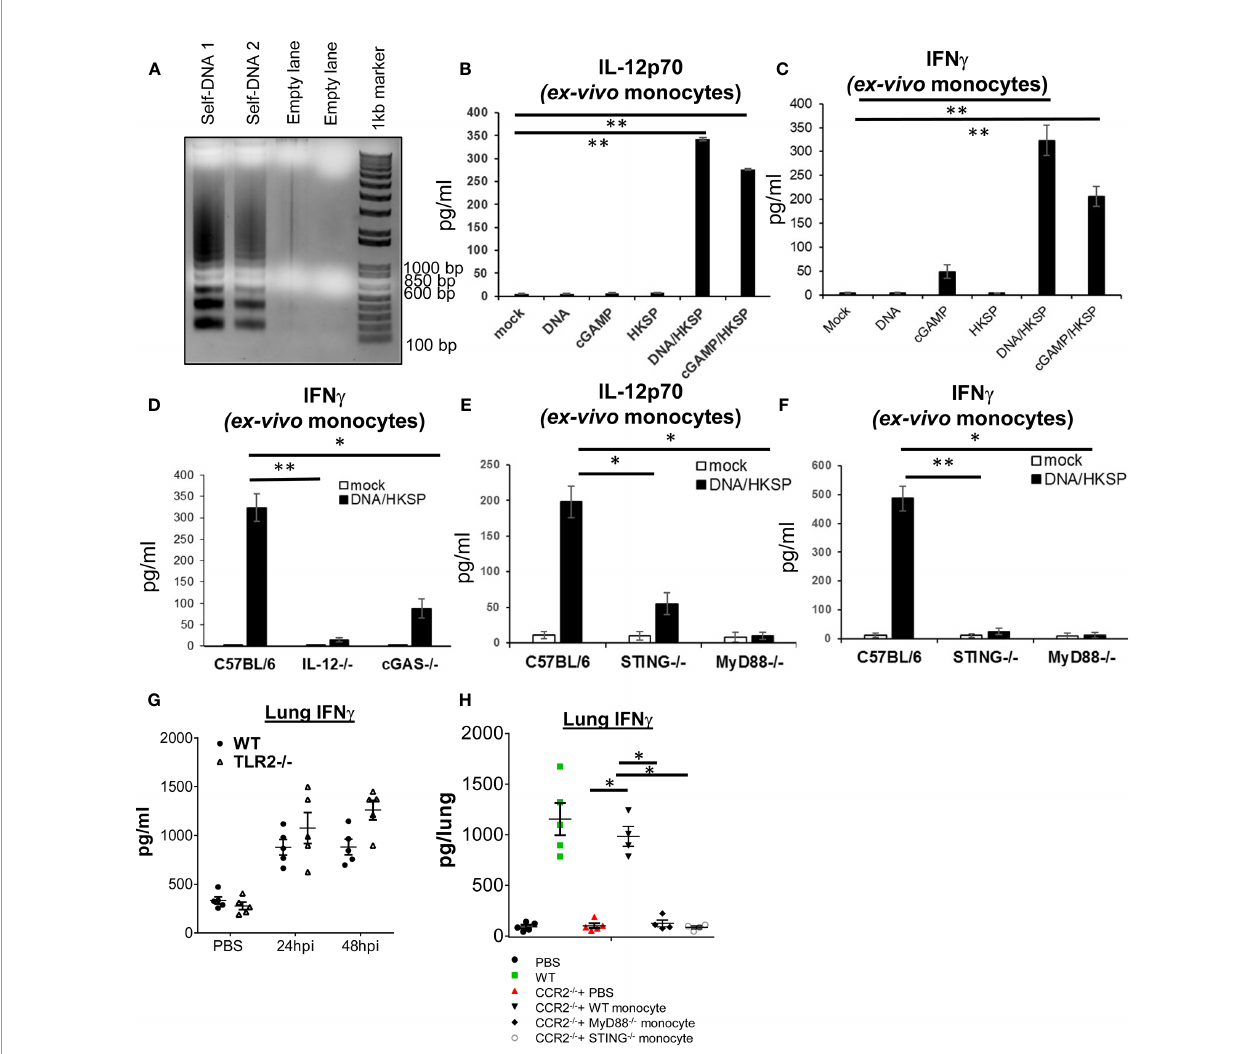
FIGURE 4 | Ly6C hi monocyte production of IL-12p70 and IFN g require the activation of both cGAS – STING and MyD88 pathways. (A) Splenocytes isolated from a C57BL/6J mouse were cultured ex vivo for 4 days. Genomic DNA was extracted and run on an agarose gel (Self DNA 1 and Self DNA2). (B, C) Ly6C hi monocyte isolated from C57BL/6J mice were activated with self-DNA (1.5 µg/ml), HKSP (5 × 10 6 CFU/ml), 2 ′ 3 ′ -cGAMP (4 µg/ml) or DNA + HKSP, HKSP + 2 ′ 3 ′ -cGAMP for 17 h IL-12p70 (B) and IFN g (C) were measured in the culture supernatant by ELISA. Data are representative of three independent experiments. (D – F) Ly6C hi monocyte isolated from indicated mice were activated with self-DNA (1.5 µg/ml) plus HKSP (5 × 10 6 CFU/ml) for 17 h as in (B) . IFN g and IL-12p70 were measured in the culture supernatant by ELISA. Data are representative of three independent experiments. (G) TLR2 − / − and their WT littermates were infected (i.n.) with PBS or S. p (D39 strain, ~5 × 10 6 CFU). IFN g in lung homogenates was measured by ELISA at 24 and 48 hpi (n = 4 – 5 mice/group). Data are representative of two independent experiments. (H) CCR2 − / − and WT littermates were infected with S. pneumoniae (D39 strain, ~8 × 10 6 CFU). At the 16 hpi, 1 million bone marrow WT, MyD88 − / − , or STING − / − Ly6C hi monocytes were adoptively transfer (i.n.) into CCR2 − / − mice. IFN g in lung homogenates were measured at 48 hpi by ELISA (n = 4 – 5 mice/group). Data are representative of two independent experiments. Graphs represent the mean with error bars indicating SEM. p -values determined by one-way ANOVA Tukey ’ s multiple comparison test. Signi fi cance is represented by asterisk, where * p < 0.05, ** p <